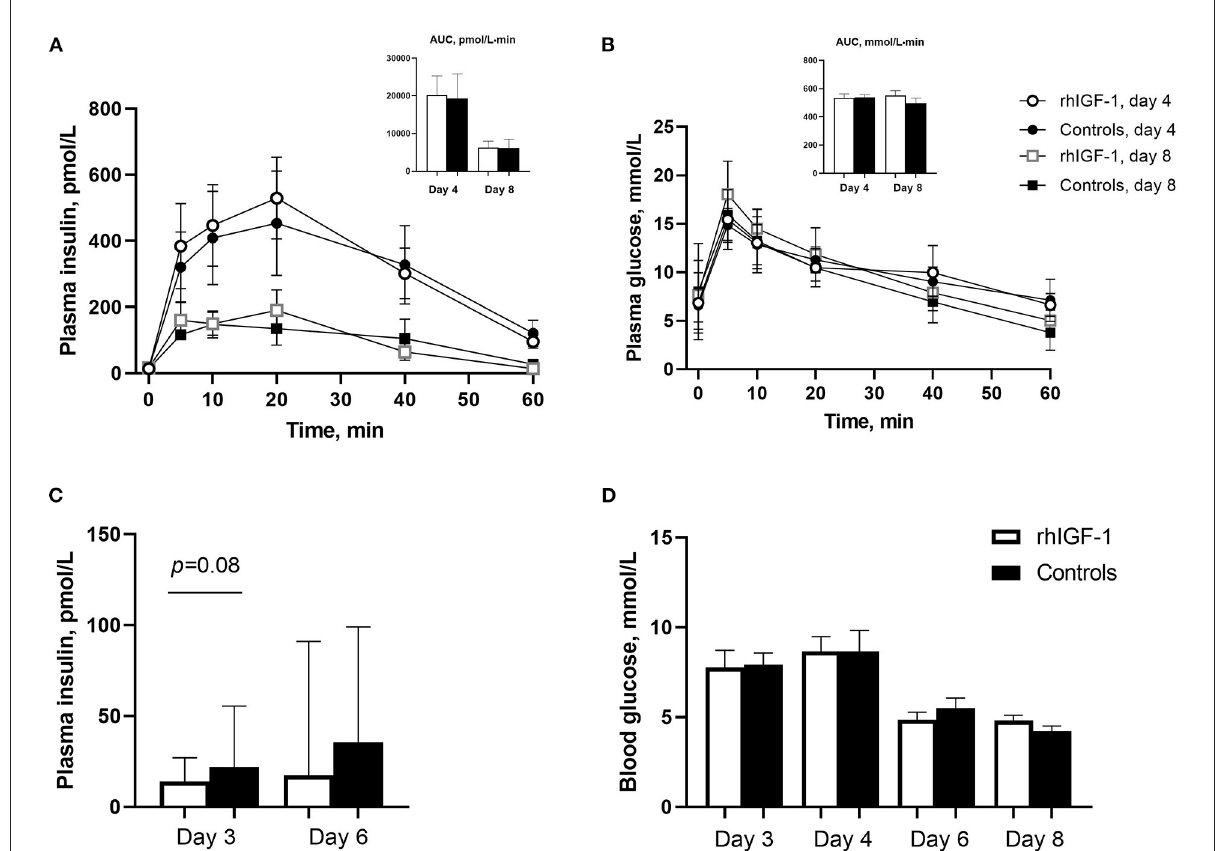
FIGURE3 Blood insulin and glucose levels in Experiment 1. Plasma insulin (A) and glucose (B) levels during glucose tolerance test in rhIGF-1 and control preterm pigs day 4 ( n = 11) and 8 ( n = 6–7). (C) Basal plasma levels of insulin in rhIGF-1 and control preterm pigs day 3 ( n = 25) and 6 ( n = 20–23). (D) Blood glucose levels in rhIGF-1 and control preterm pigs day 3 ( n = 24–25), 4 ( n = 24–25), 6 ( n = 22–23) and 8 ( n = 14–18). rhIGF-1, recombinant human insulin-like growth factor-1; AUC, area under the curve. Values in (A,B,D) are presented as mean ± SEM. Values in (C) are presented as median ± IQR.